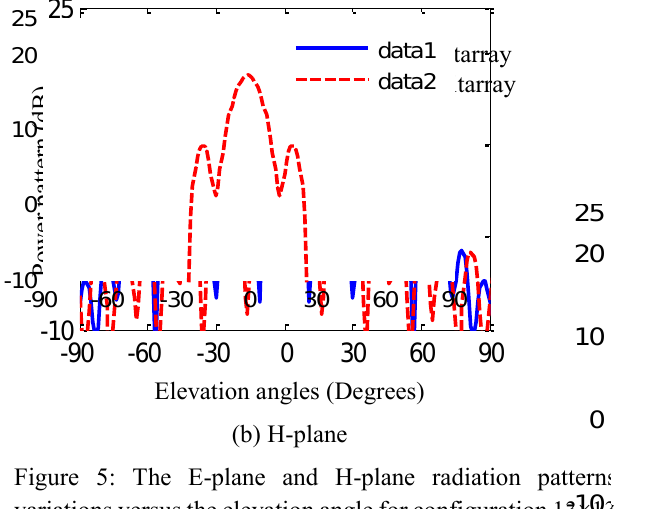
Figure 5: The E-plane and H-plane radiation patterns variations versus the elevation angle for configuration 13×13 FF focused transmitarray and 13×13 NF focused transmitarray at F/D = 0.9 and frequency 10 GHz.